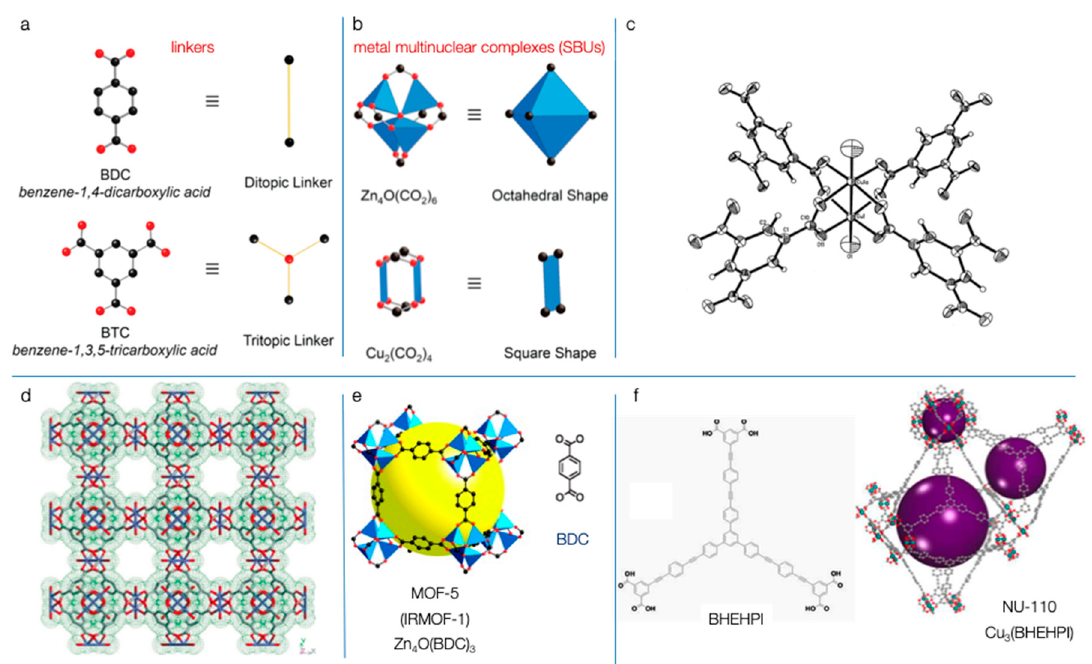
Figure 1. ( a ) The linkers [32]; ( b ) the metal clusters / multinuclear complexes (Secondary Building Units, SBUs) of HKUST-1 and MOF-5 (color assignation: black for C, red for O, blue for Cu squares and Zn polyhedrals; H atoms are omitted) [32]; ( c ) the dicopper(II) tetracarboxylate building block of HKUST-1 [30]; ( d ) the polymeric framework of HKUST-1 (viewed down the direction) [30]; ( e ) the single crystal structure of MOF-5 (the yellow spheres represent the maximum volume of the biggest cavity) [33]; ( f ) the chemical structure of the ligand and the different cages of the NU-110 framework [34].